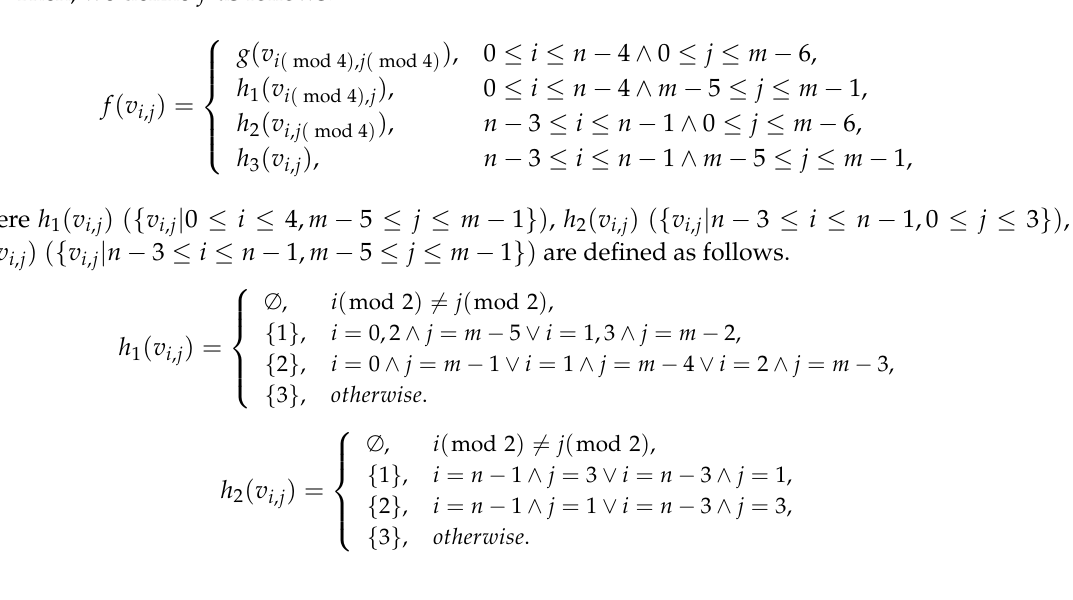
2 ( mod 4 ) Figure 5. f on some C ≡